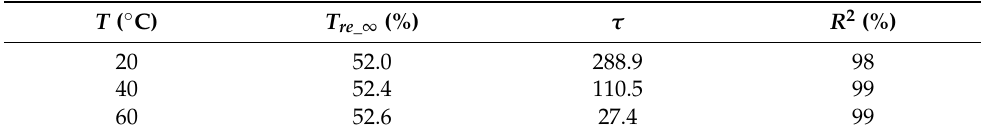
Table 5. Determined values of T re _ ∞ and τ (G2).